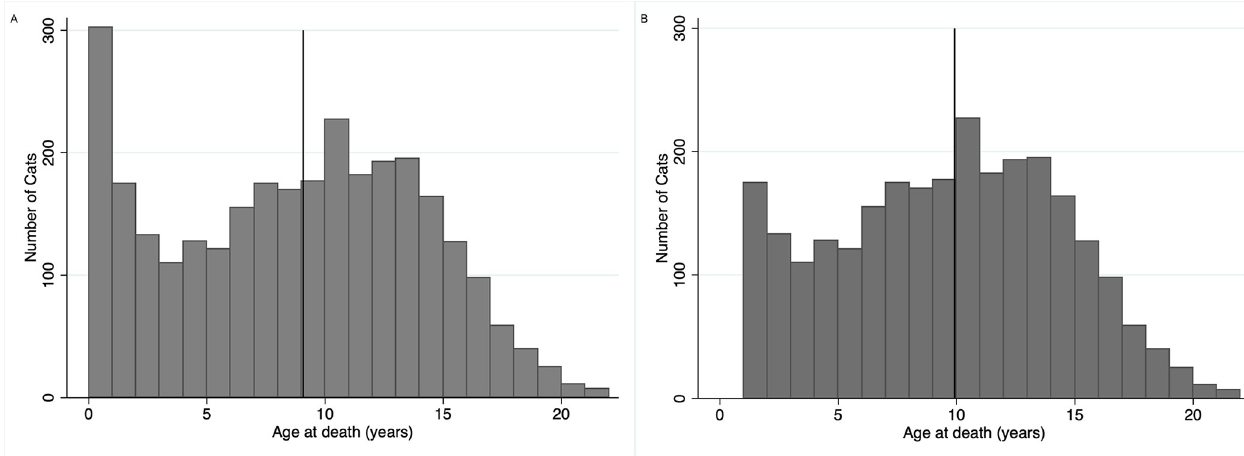
Fig 1. Distribution of age at death for cats (A) Histogram showing the ages of death for the 2,974 cats in the study for which their age was known. The line represents the median age of death at 9.07 years. (B) Histogram showing the ages of death for the 2,672 cats in the study for which their age was known and they were � 1 year. The line represents the median age of death at 9.92